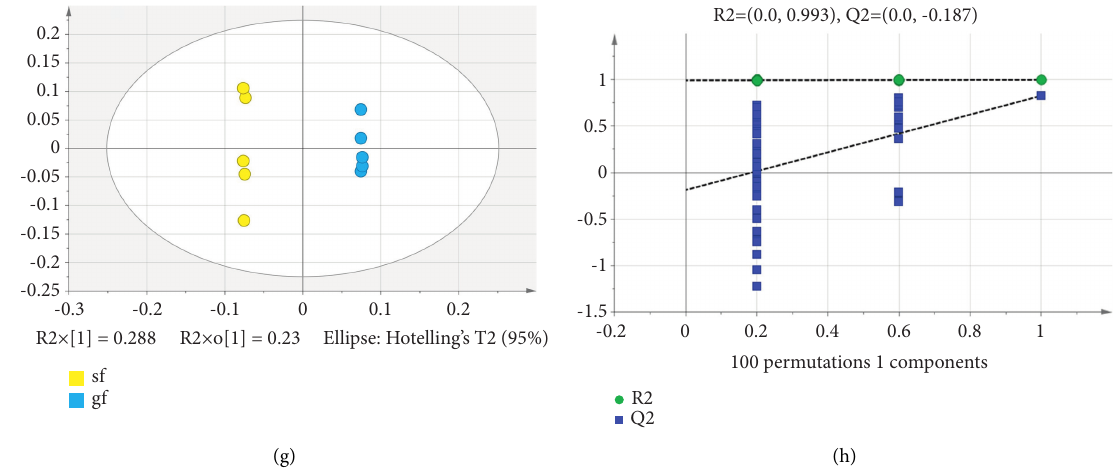
Figure 5: Scatter plot and permutation test plot of OPLS-DA models.